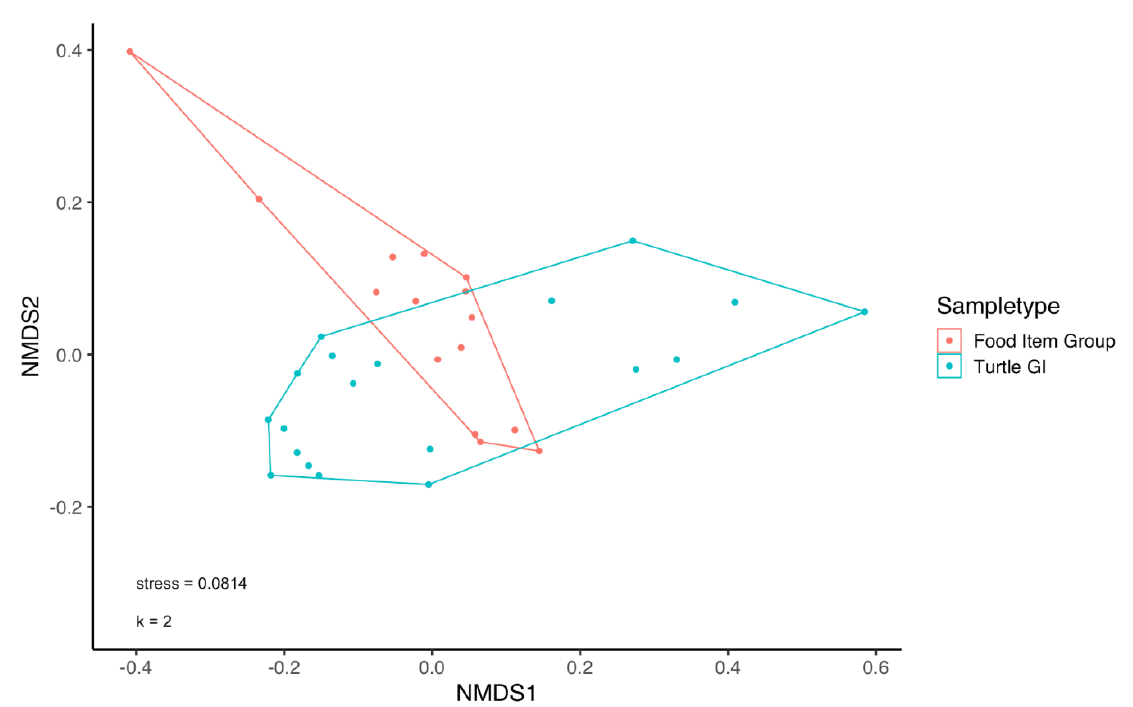
Figure 2. Microbial community structure organized according to the origin of samples collected for this study: green turtle gastro-intestinal (GI) compartments and green turtle putative food item groups (macroalgae and seagrass species). NMDS plot based on Bray-Curtis.